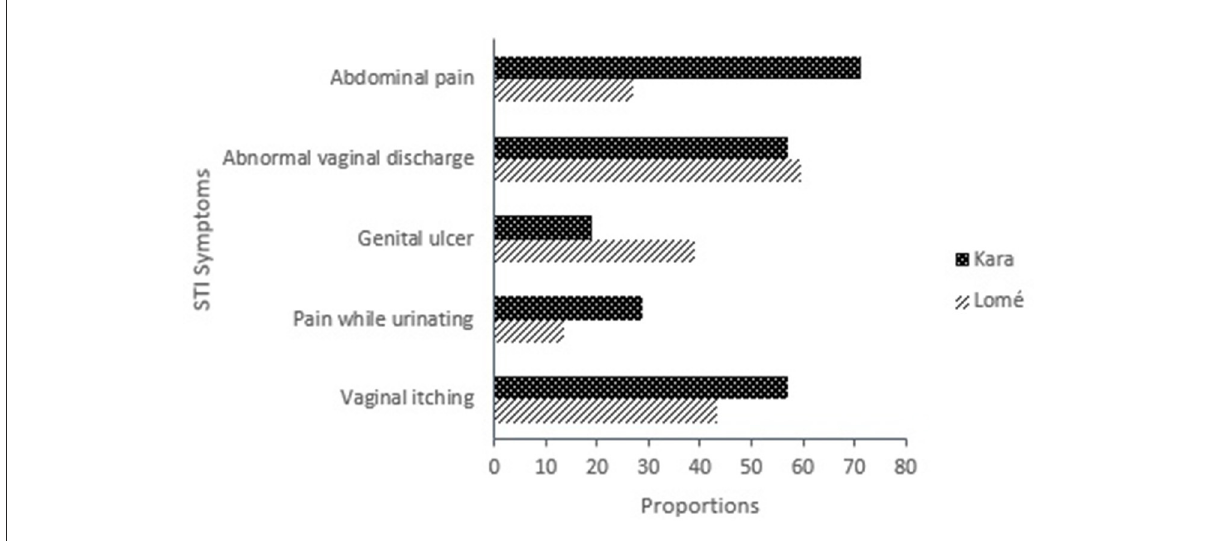
FIGURE1 Self-reported current STI symptoms among FSW in Togo in 2021 ( n =